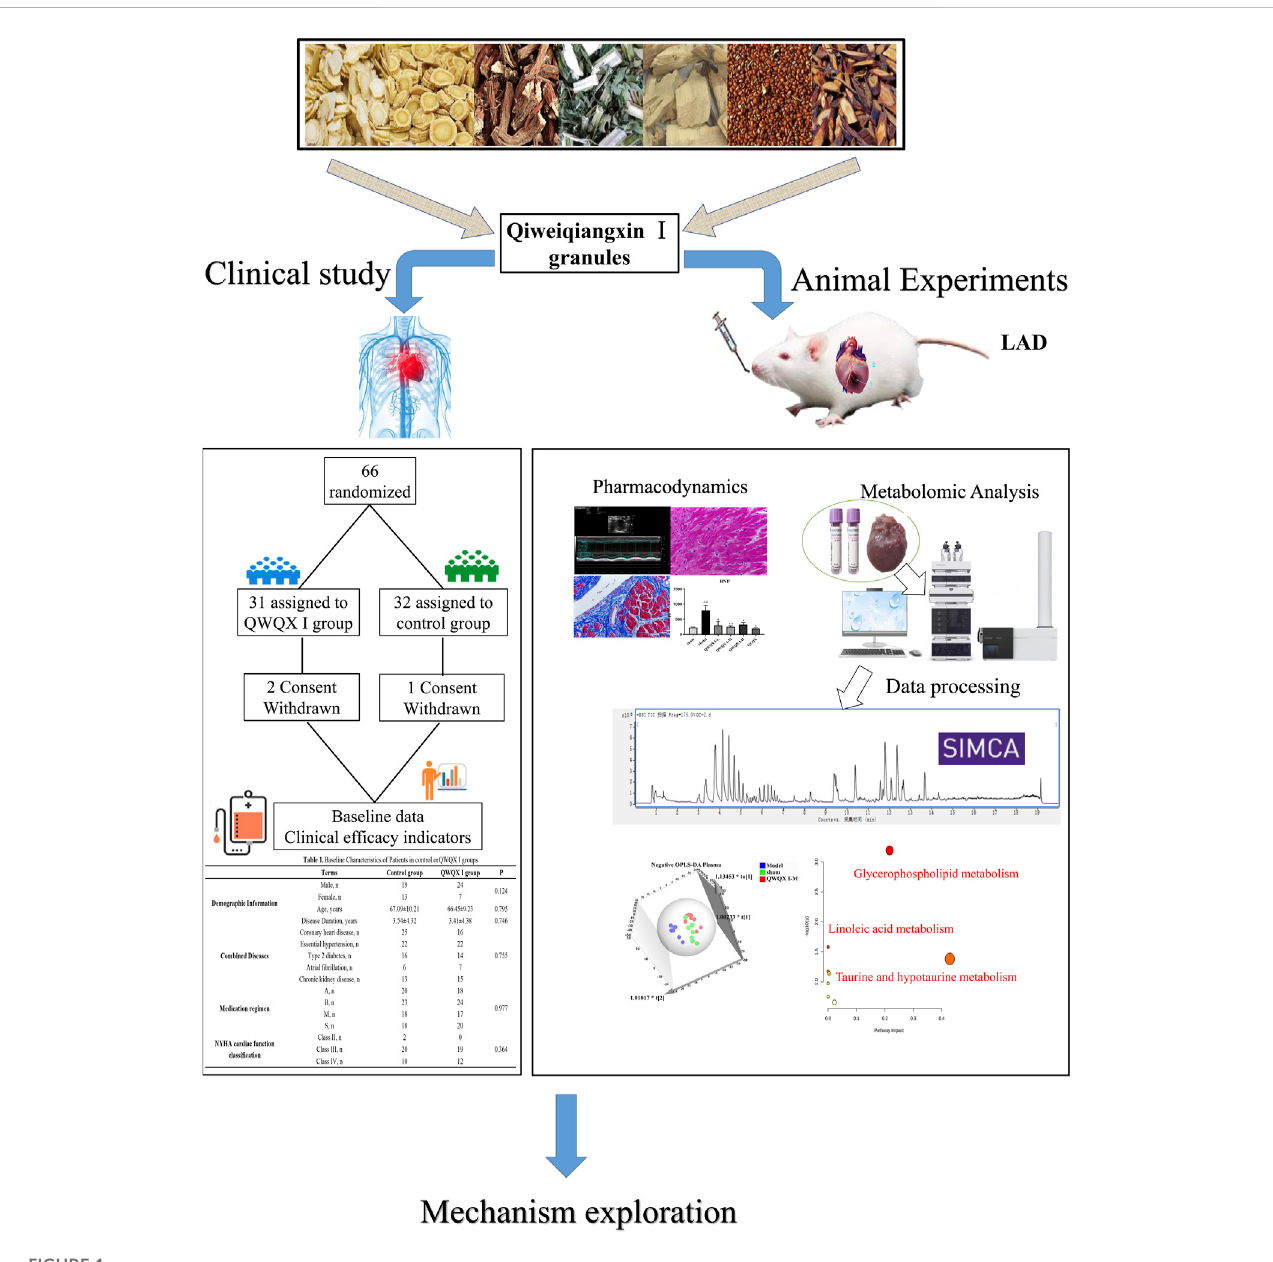
FIGURE 1 Research framework of this